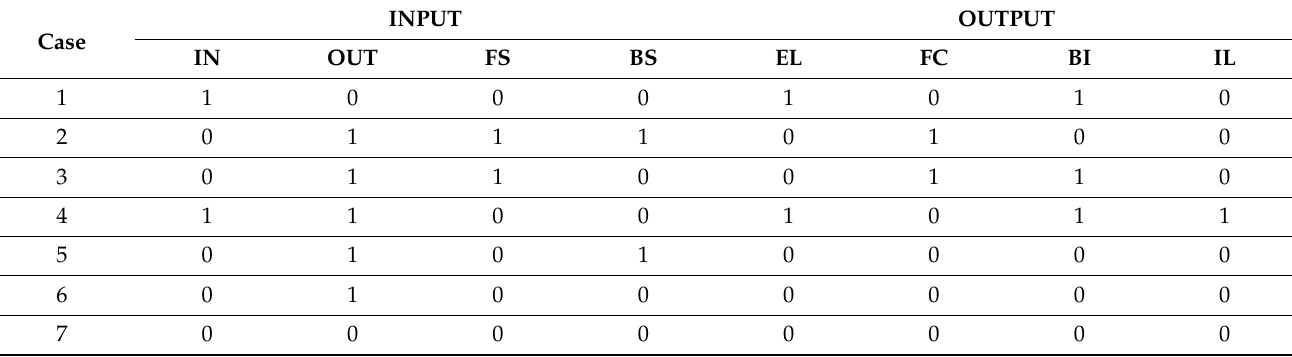
Figure 4. Flowchart of the switching algorithm. Table 1. Switching algorithm with